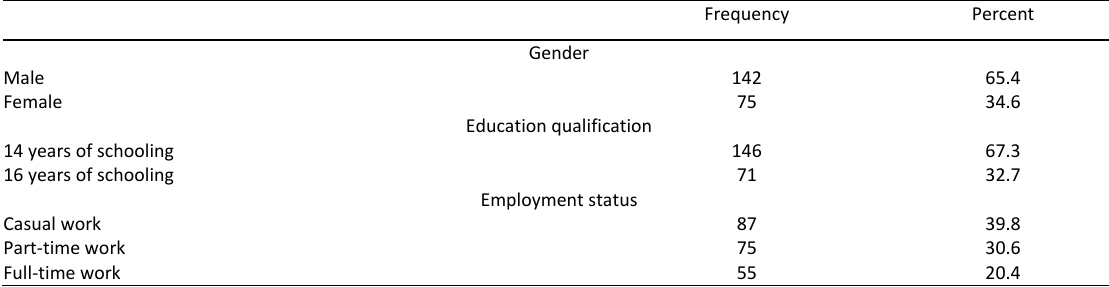
Table 1: Respondents